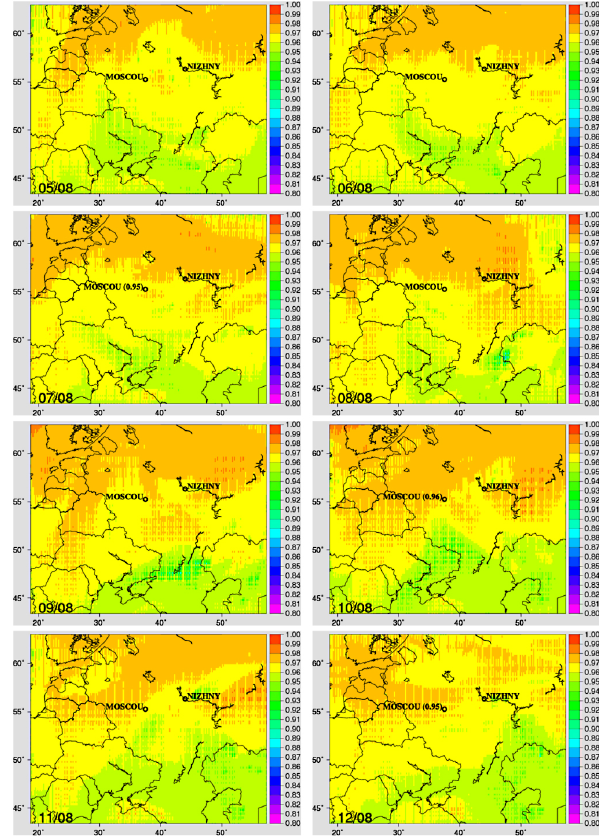
Fig. 3. Geographic distribution of the daily mean SSA over east- ern Europe from 5 to 12 August 2010 modelled by CHIMERE (at 400nm) and measured at the Moscow AERONET station (at 440nm) during 7, 10 and 12 August (no data are available for the others days of the studied period).